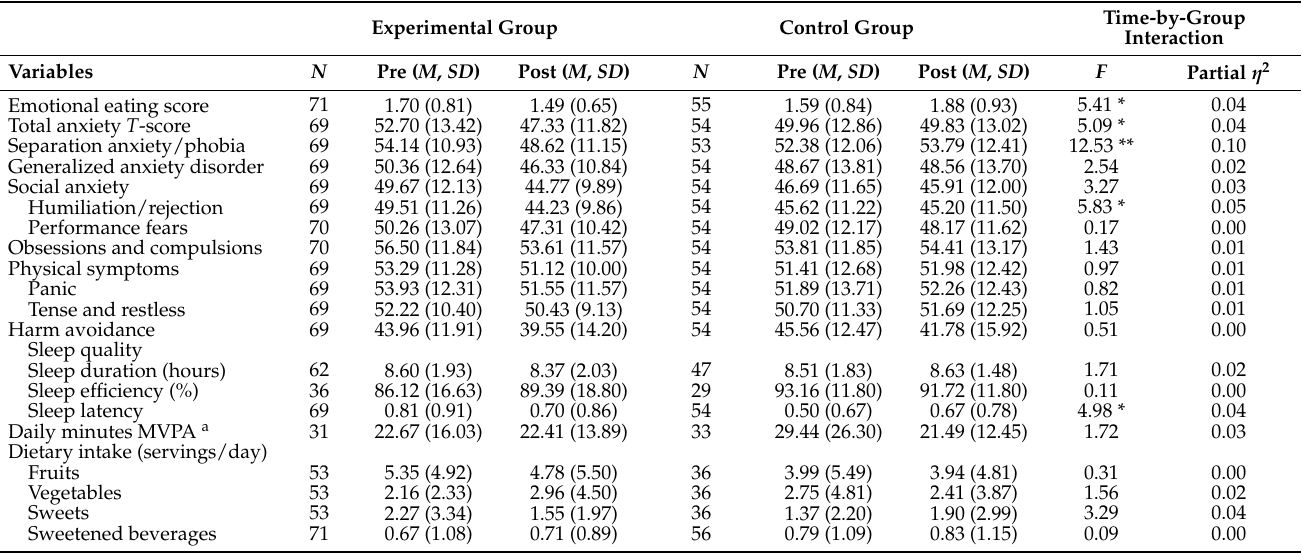
Table 3. Pre- and post-intervention changes in outcome variables between the experimental and control